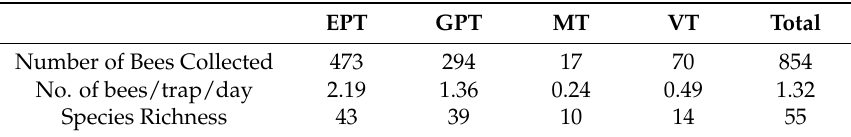
Table 5. Summary of number of bees and species richness collected using four sampling methods in oak-hickory forest in Hancock County, IL, USA, April–September 2011. EPT = elevated pan trap, GPT = ground-level pan trap, MT = malaise trap, VT = vane trap. EPT GPT MT VT Total Number of Bees Collected 473 294 17 70 854 No. of bees/trap/day